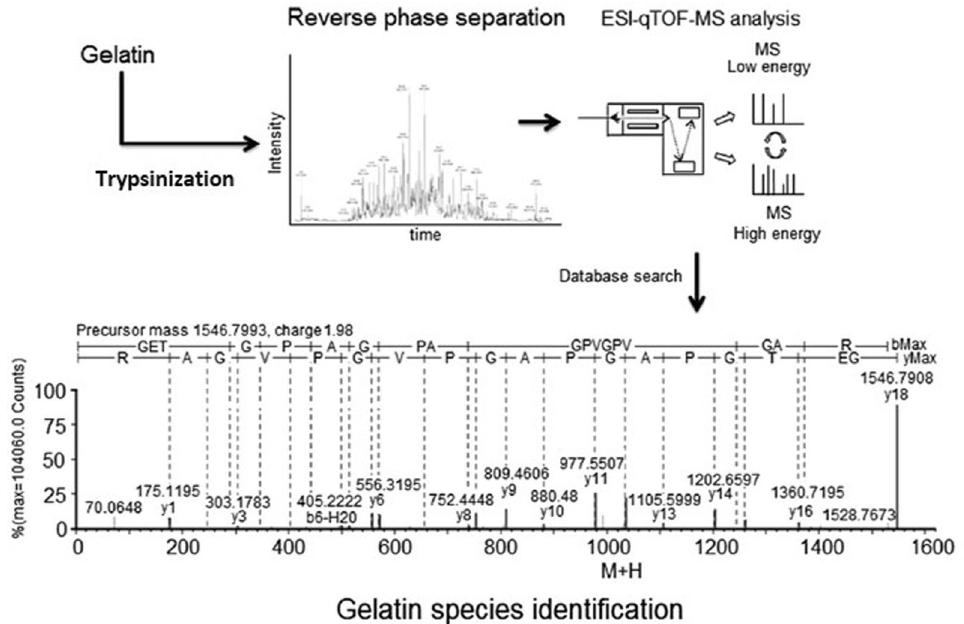
Fig. 5 Workflow for NanoUPLC-ESI-Q-TOF-MSE for gelatin source identification. Yilmaz et al. (2013) Copyright (2013) with permission from Elsevier